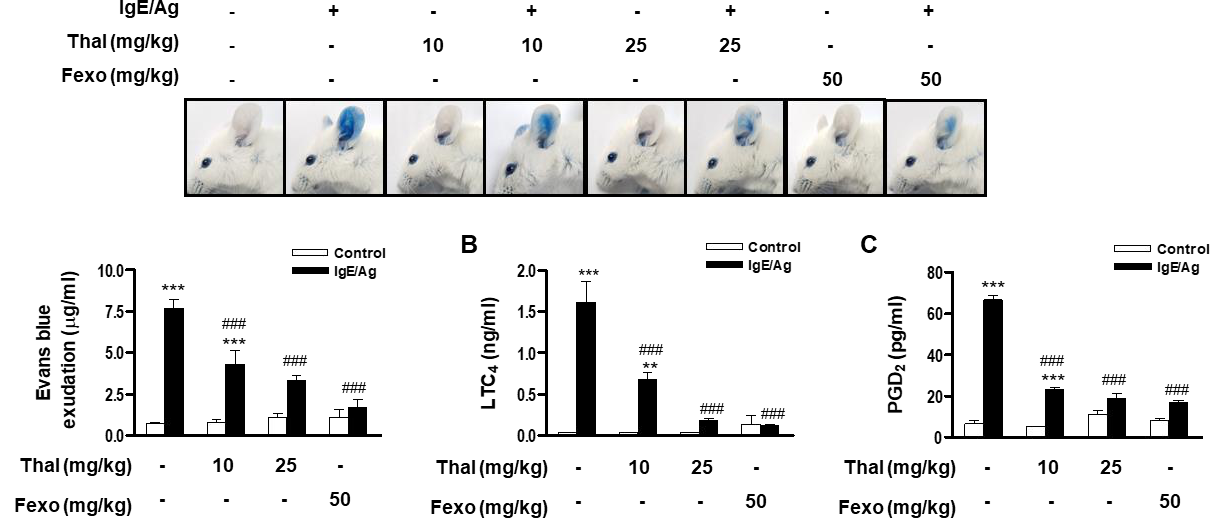
Figure 6. Thalidomide ameliorates IgE/Ag-mediated PCA reaction in mice. Mice were intradermally sensitized with IgE on the ears and were intravenously challenged with DNP-HSA (Ag) containing 1% evans blue. Thalidomide (Thal), fexofenadine (Fexo), or vehicle were given orally 1 h prior to DNP-HSA (Ag) challenge. The amount of dye extraction was measured as described in the Materials and Methods section and presented. Top panels show the representative photos of ears with dye extravasation ( A ). The levels of serum LTC 4 ( B ) and PGD 2 ( C ) were evaluated and data represent mean ± SEM (n = 6 mice per group; ** p < 0.01 and *** p < 0.001 vs. control in each treatment; ### p < 0.001 vs. IgE/Ag alone).